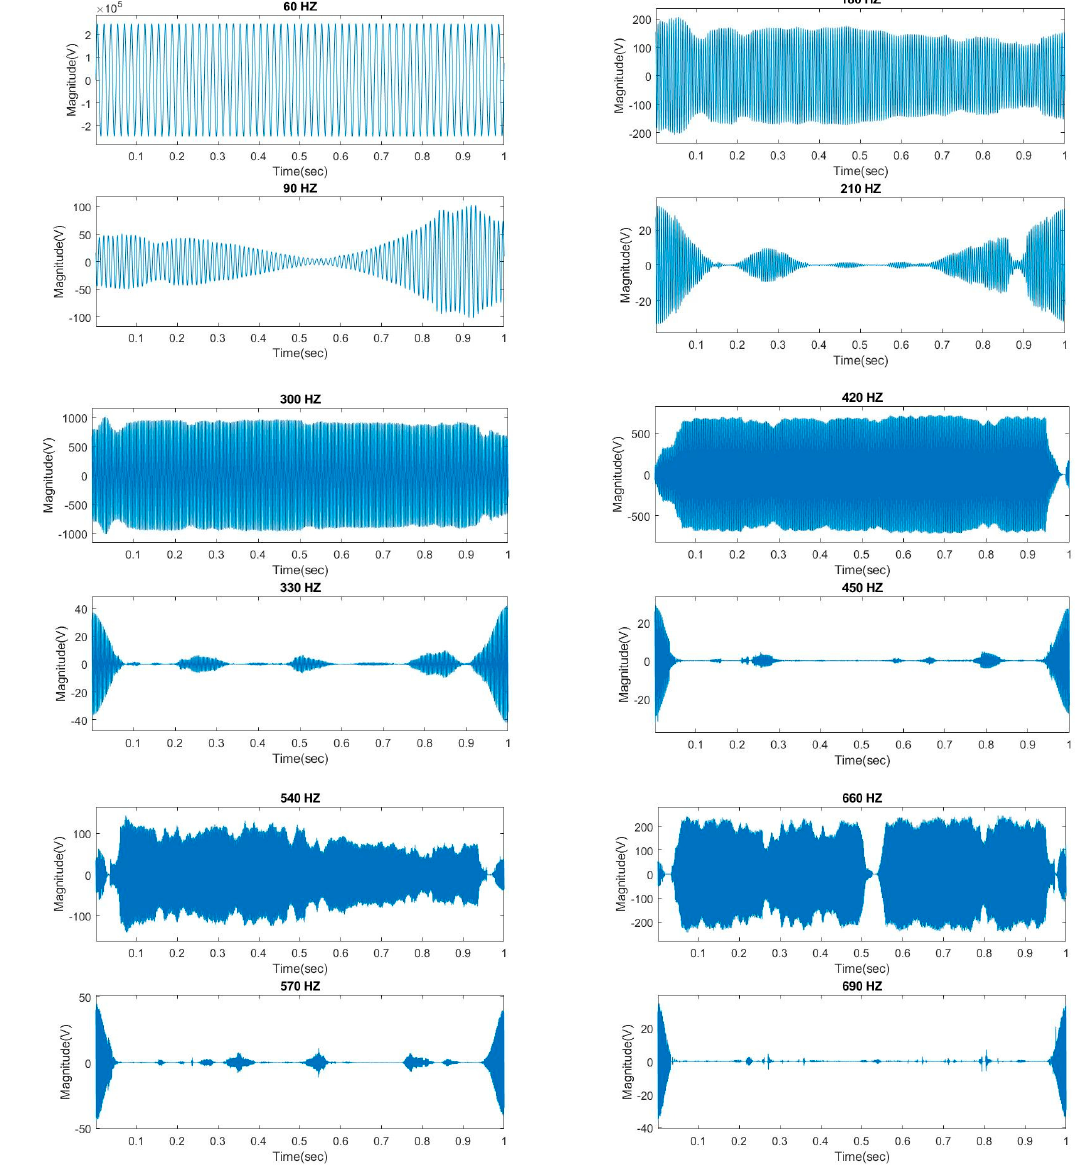
Figure 13. Offshore wind farm case: selected reconstructed time-domain waveforms up to 690 Hz corresponding to Figure 12b.